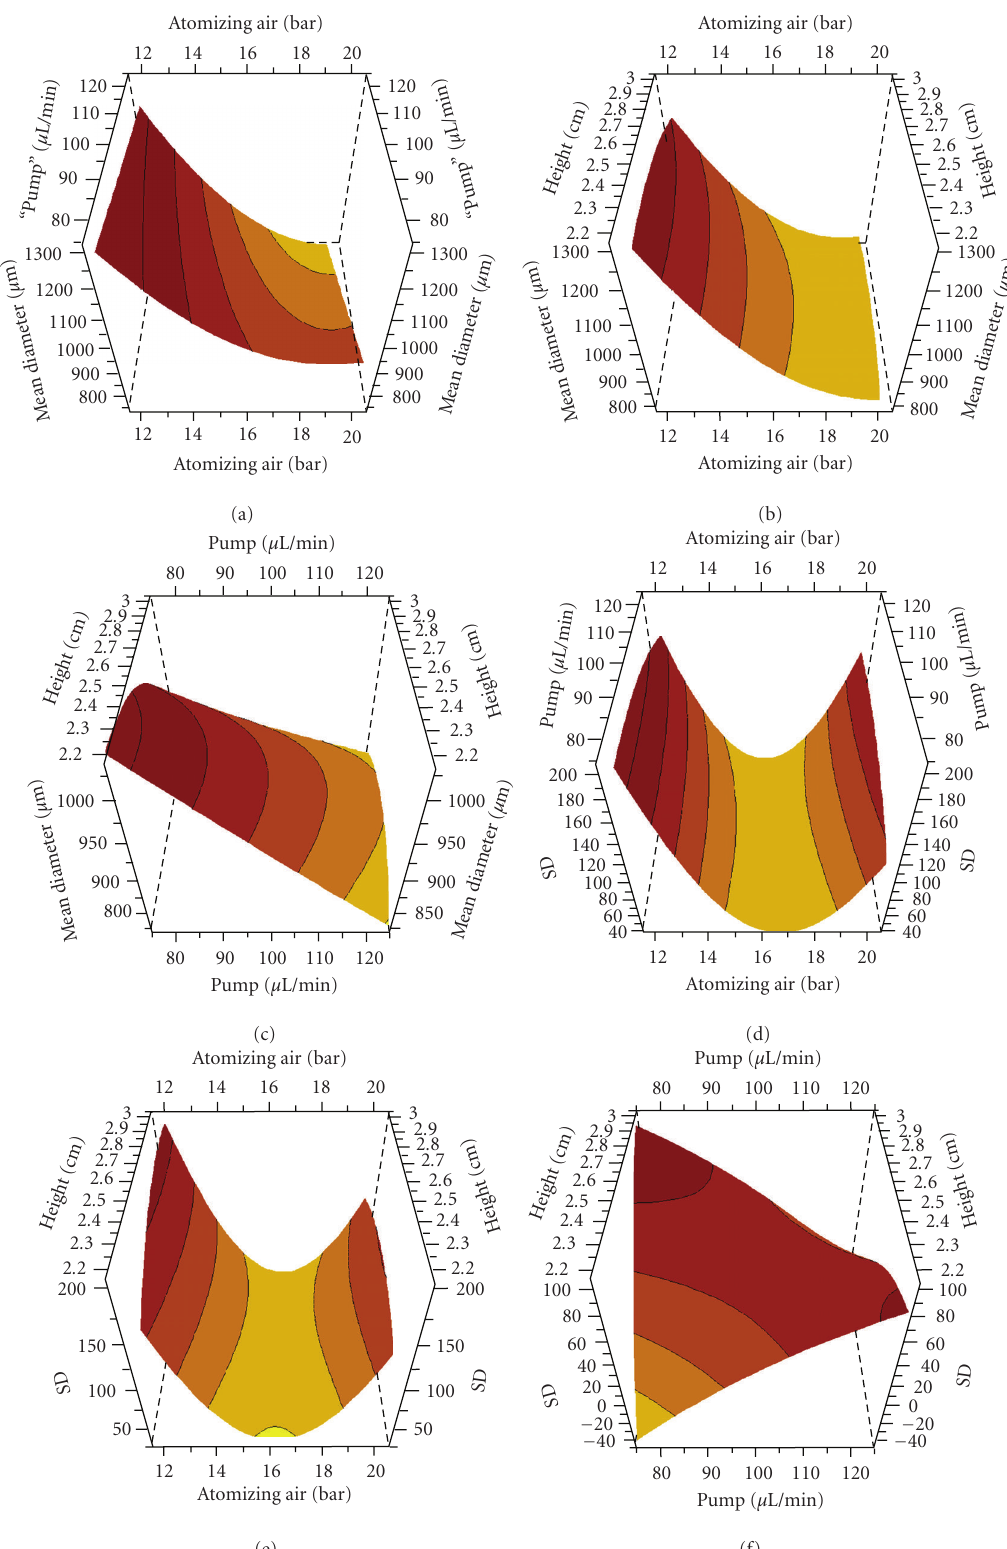
Figure 5: DoE analysis for the production of alginate microbeads containing IB3-1 cells. Response surface plots of the responses: “size” (a)–(c) and “SD” (d)–(f). The following interactions were reported: “air versus pump” (a,d); “air versus height” (b,e); and “pump versus height”